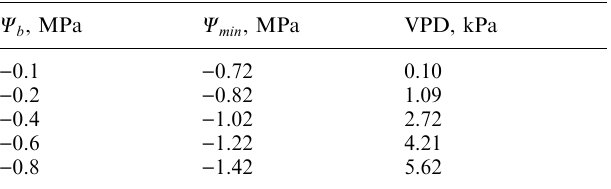
Table 2. Theoretical minimum values of the shoot water potential (cid:87) min and the corresponding atmospheric evaporative demands (VPD) causing water potential to approach the minimum value predicted from the model for di(cid:128)erent levels of the soil water status (cid:133) (cid:87)